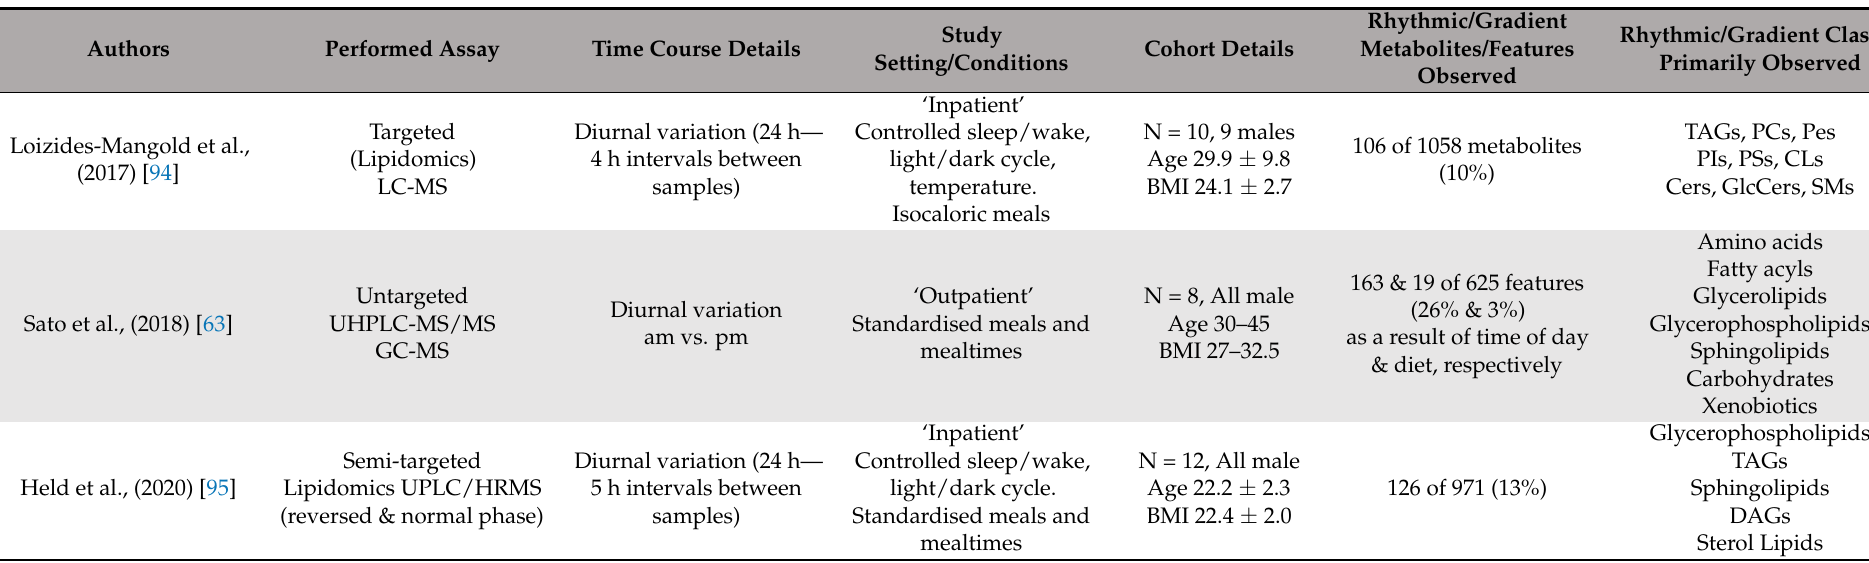
Table 6. A brief summary of study design, cohort details and results with regard to observed time of day variation of metabolites for relevant studies analysing skeletal muscle.